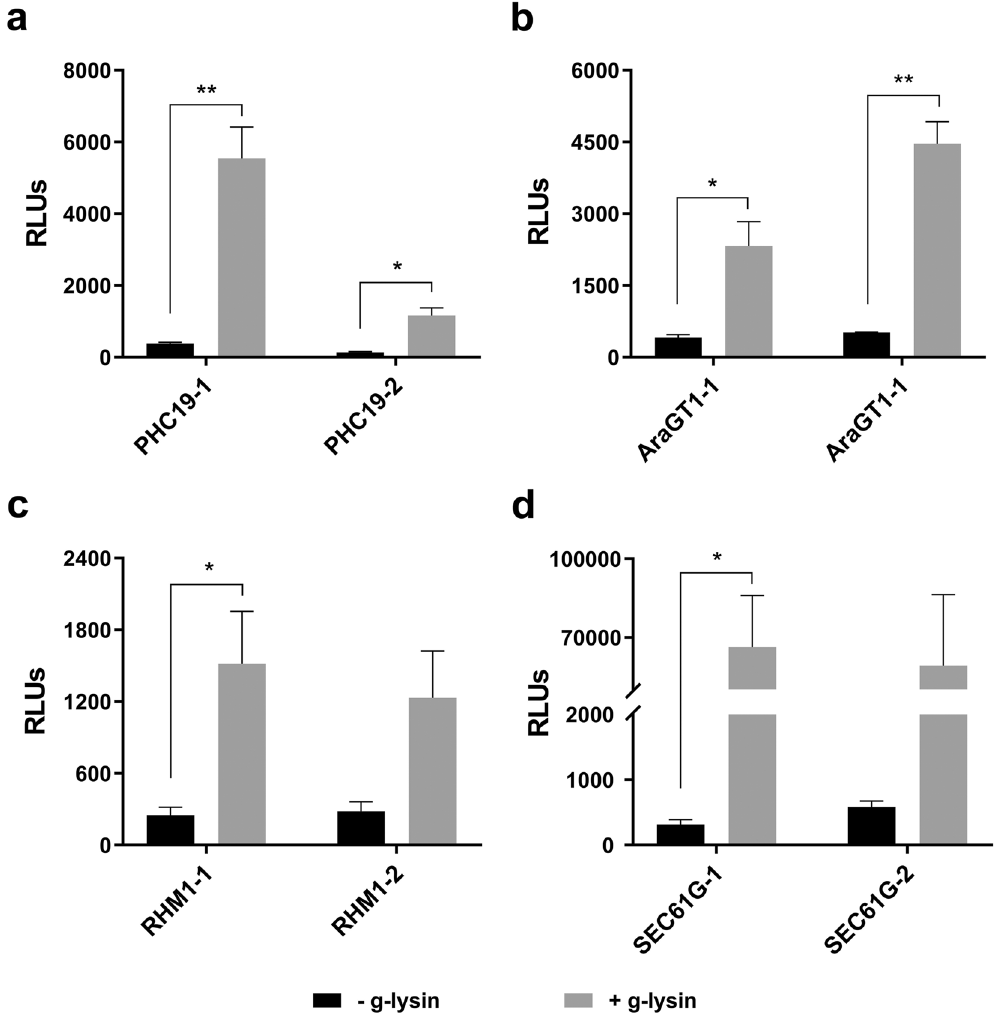
Figure 2. Promoter-driven luciferase activity increases in response to g-lysin treatment. Bar graphs represent the change in promoter activity of PHC19 ( a ), AraGT1 ( b ), RHM1 ( c ), and SEC61G ( d ) genes, using two independent promoter-transformed lines. Luciferase activity is expressed as relative light units (RLUs) based on luminescence quantification. Untreated gamete control samples are represented by black bars. Grey bars represent gamete cells treated with g-lysin. Error bars are one standard deviation from the mean of biological triplicate data. Welch’s t-test indicates statistical significance at p ≤ 0.05 ( * ), p ≤ 0.01 ( ** ); α = 0.05. RHM1-2 and SEC61G-2 showed a large variation that resulted in significance at 0.055 and 0.064, respectively, below the 95%